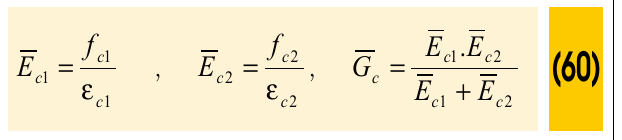
beams (ET1, ET2, ET3 and